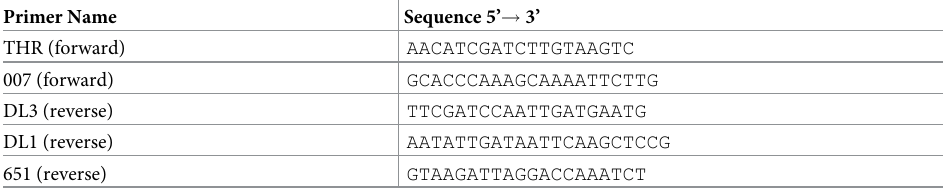
Table 2. Primers used for PCR amplification of the mitochondrial D-loop. Primers THR (forward) and 651 (reverse) were used for initial amplification of entire ~1300 bp. Internal primers 007 (forward), DL3 (reverse), and DL1 (reverse) were used for Sanger sequencing (Shaffer & McKnight,